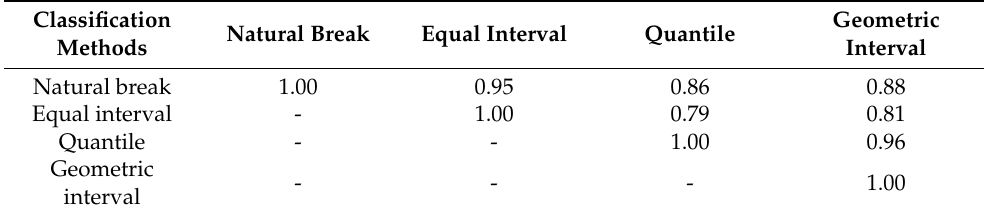
Table 7. Pearson’s correlation among the susceptibility maps obtained by using four different classification